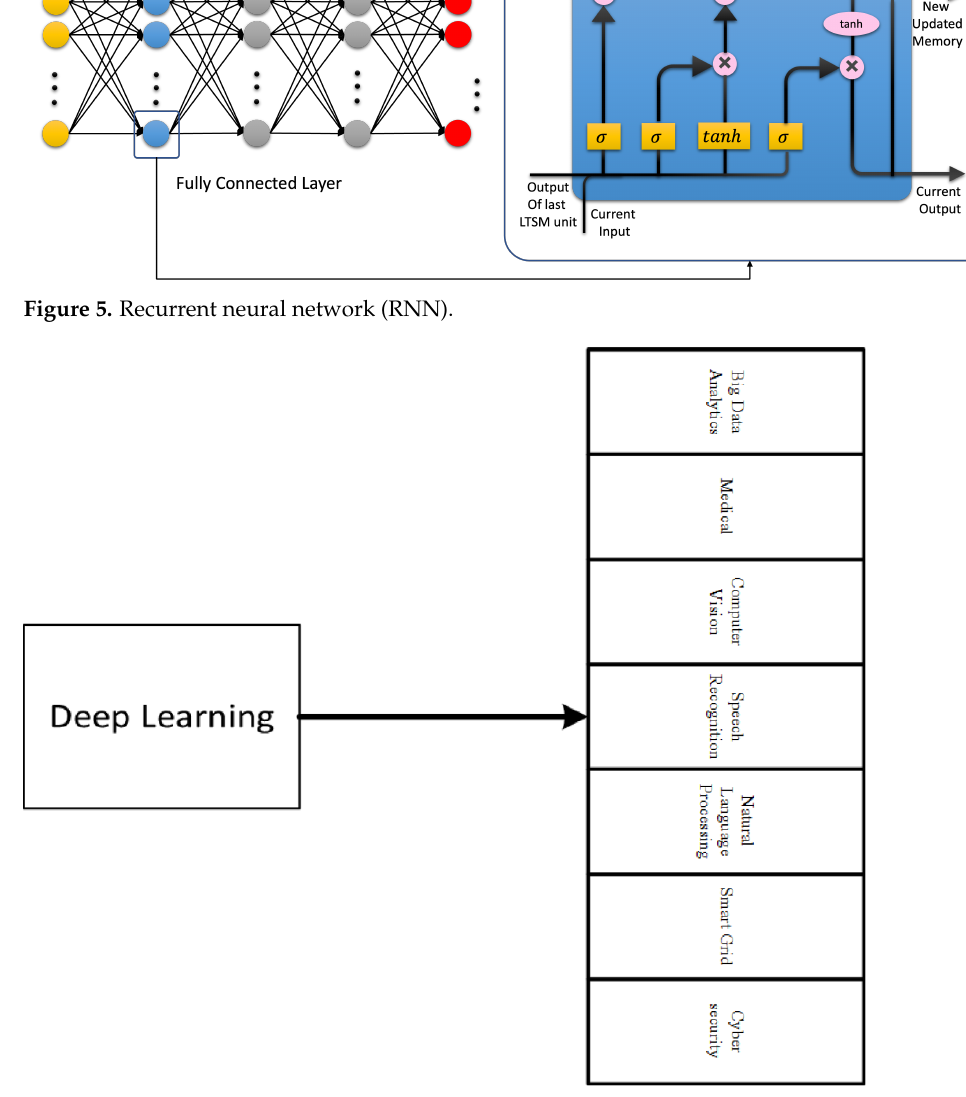
Figure 6. Deep learning